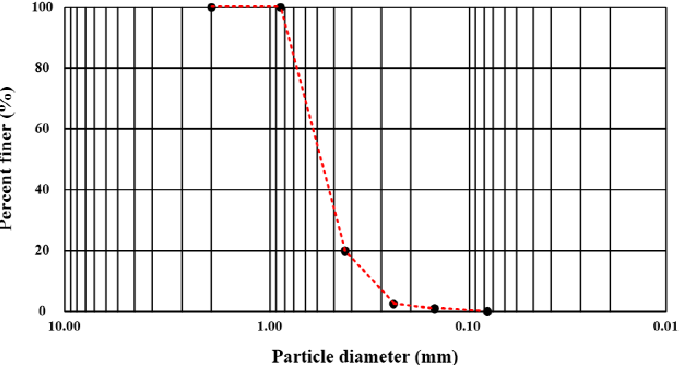
Figure 7. Particle size distribution curve for Joomunjin sand [19].